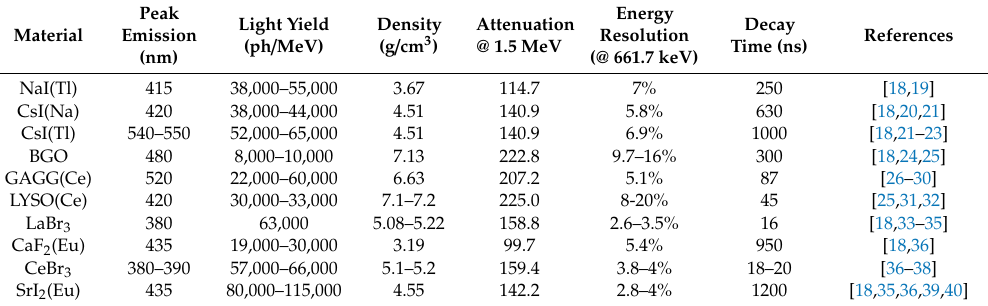
Table 1. Summary of key properties for candidate scintillator